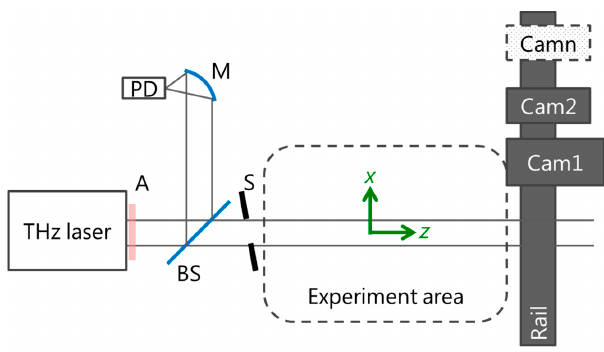
Figure 1. Experimental set ‐ up, schematic. A: Teflon absorber plate; PD: Pyroelectric detector; M: Focusing Mirror; BS:; 10/90 beam splitter; S: shutter; Camn: Camera #n.